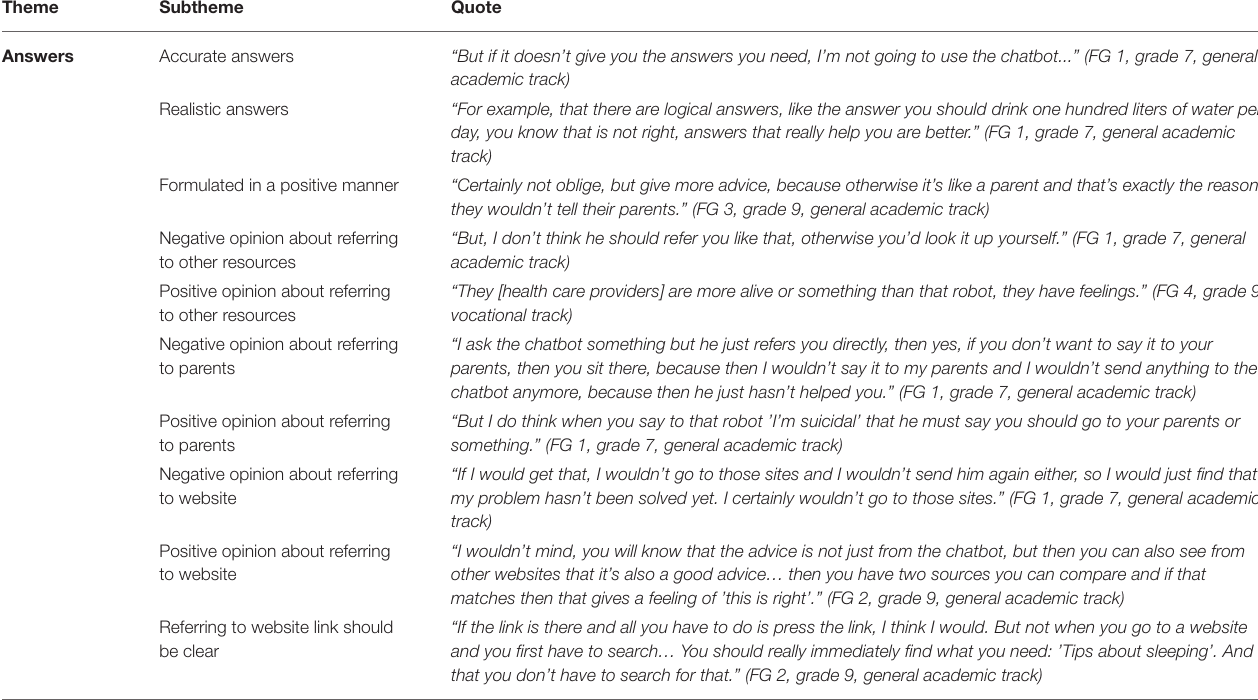
TABLE 3 | Results from the focus groups regarding answers adolescents would expect. Theme